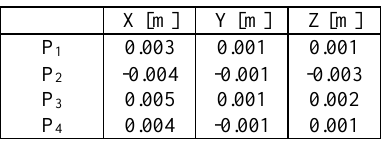
Table 3. Residuals between the target points used to georeference the different scans